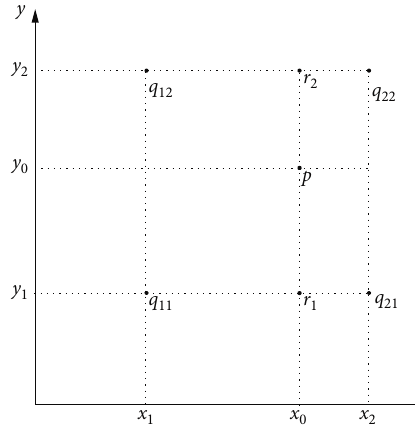
Figure 5: Two-dimensional